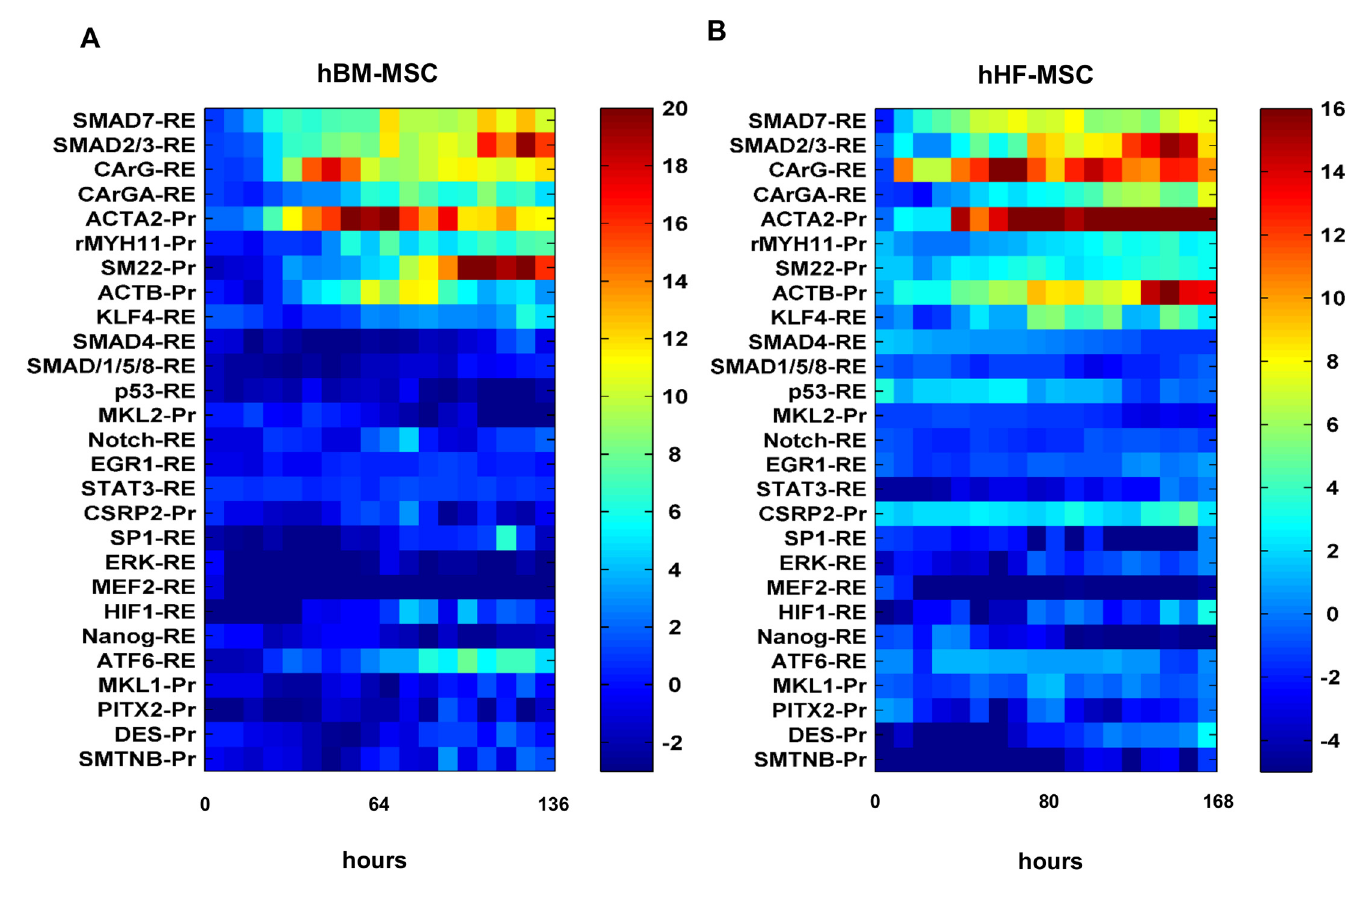
Fig 4. Heatmaps of Pr/RE responses. Standardized fold change (Welch ’ s t- statistic) of normalized intensity in DM over GM for (A) hBM-MSC or (B) hHF-MSC was plotted as a function of time for 27 Pr/RE. The color bar represents the standardized fold change on a scale of ( A) -3 to +20 and ( B) -5 to +16. The color gradient ranges from blue (no significant change) to red (highly